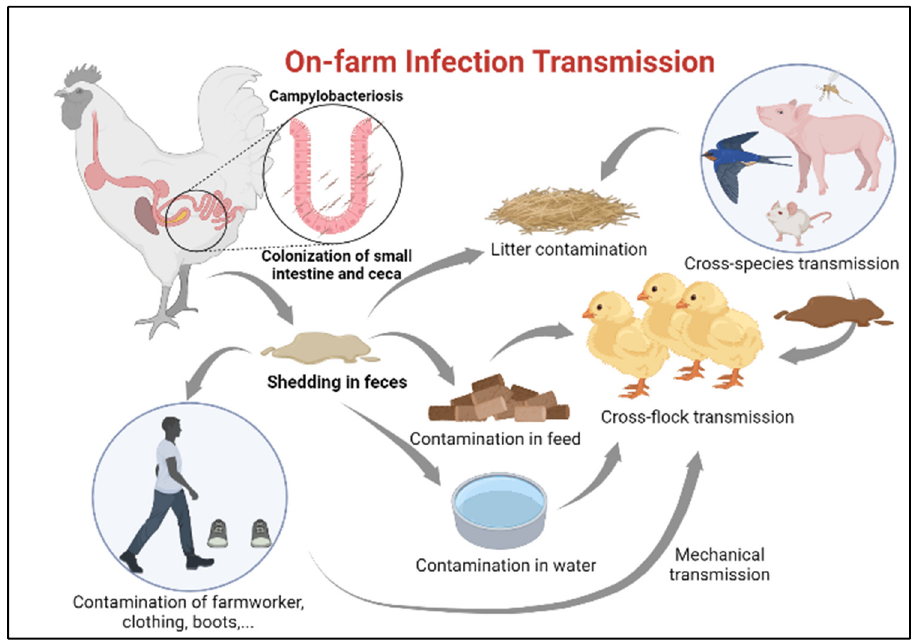
Figure 2. On-farm infection